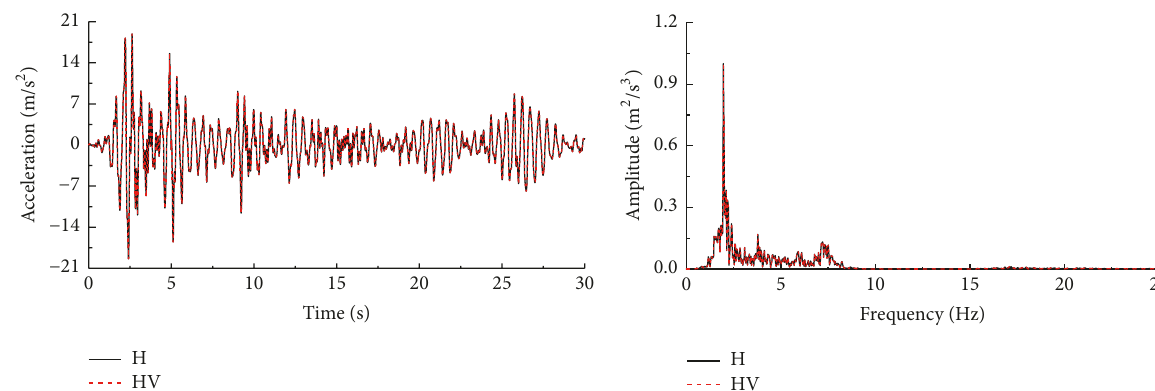
Figure 14: Horizontal acceleration time history and spectrum curves at node 103 under EL wave for H and HV case.